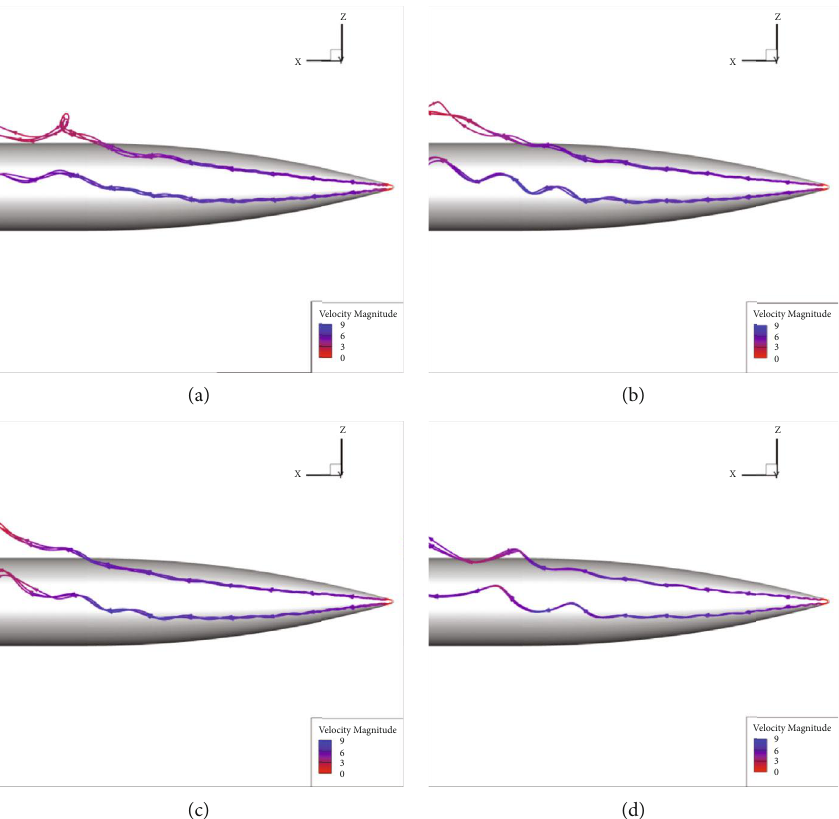
Figure 24: Comparison of streamline with di ff erent roughness values: (a) Model 1, (b) Model 2, (c) Model 3, and (d) Model